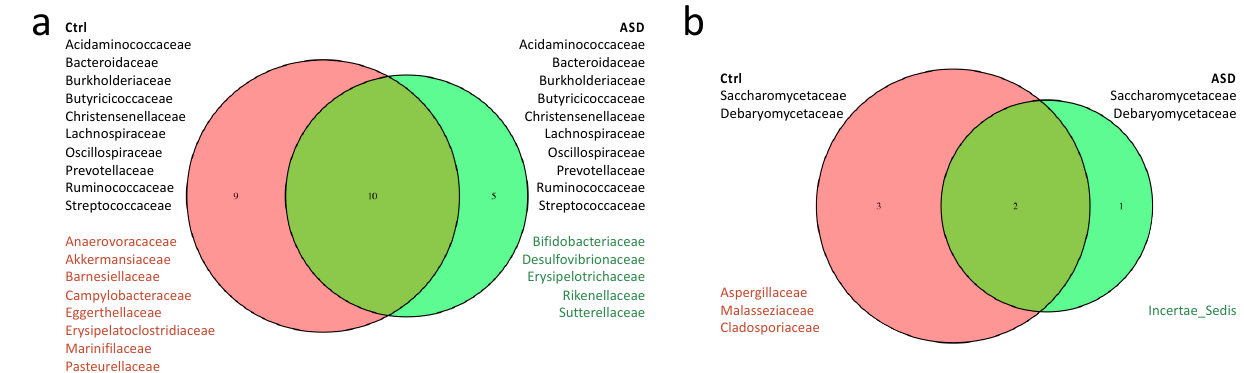
Figure 1. Alpha diversity analysis. Alpha diversity analysis with Shannon and Simpson indices of 16S ( a ) and 18S ( b ).